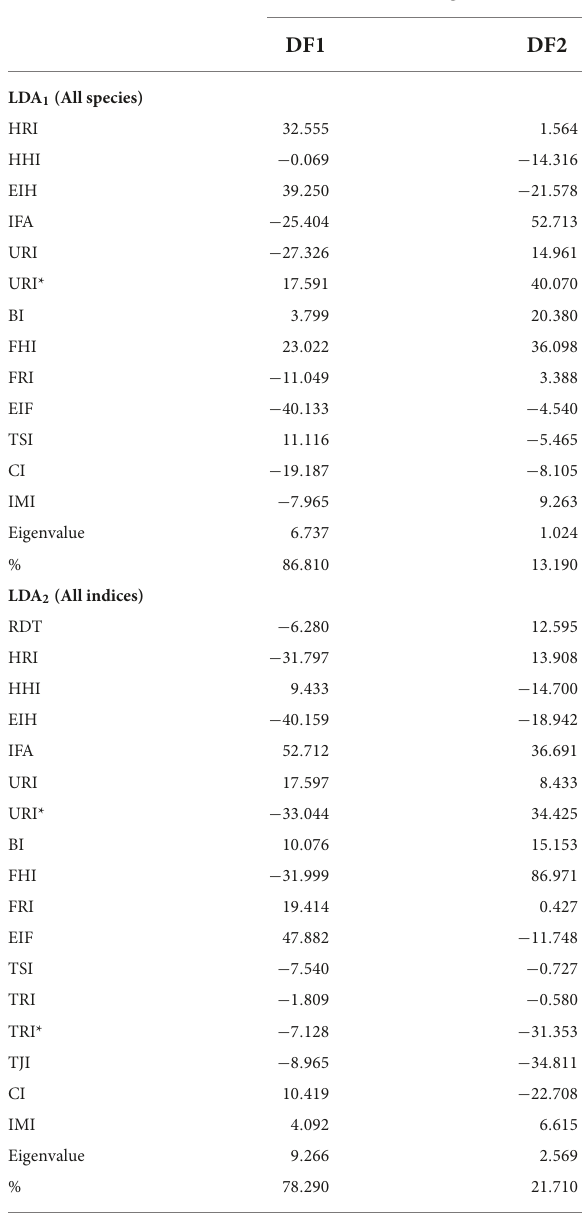
TABLE 6 Loadings, eigenvalues, and proportion of variance explained by each function of the discriminant analysis, including all species (LDA 1 ) and all indices (LDA 2